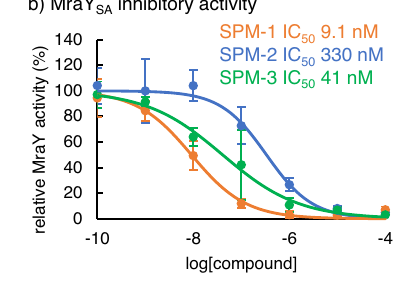
Fig. 7 | MraY inhibitory activity of SPMs. a The inhibitory activities of the com- pounds against puri fi ed MraY AA . Assays were conducted with 100mM Tris-HCl, 500mM NaCl, 10mM MgCl 2 , and 20mM (3-((3-cholamidopropyl) dimethy- lammonio)-1-propanesulfonate), 150 μ M UDP-MurNAc-pentapeptide, 250 μ M C 55 -P,andMraY AA (50nM).After5minofincubationat45°C,theformationofUMP was monitored by luminescence measurement. b The inhibitory activities of the compounds against puri fi ed MraY SA . Assays were conducted with 50mM Tris-HCl